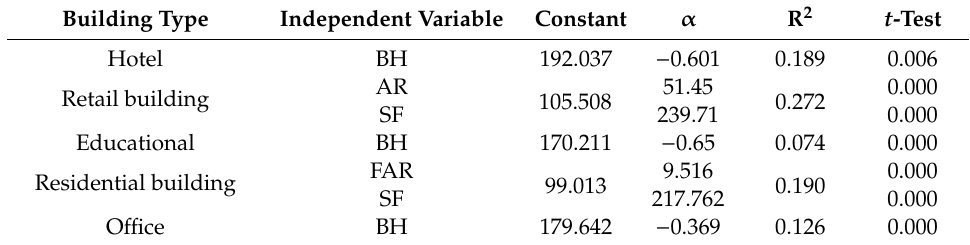
Table 7. Stepwise regression result and t -test of urban morphological